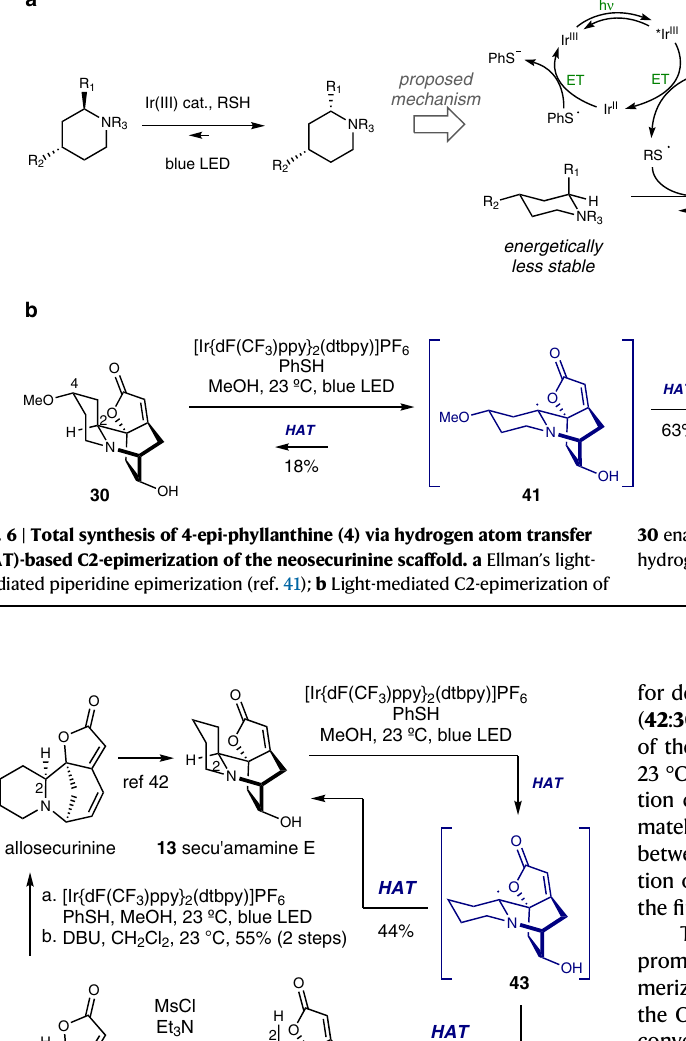
Fig. 7 | Interconversion between allosecurinine (2) and securinine (1) via HAT- based C2-epimerization. The light-mediated HAT-based epimerization of piper- idinesenabledtheinterconversionbetweensecu ’ amamineEand ent -virosineB,the neosecurinane derivatives of allosecurinine and securinine, respectively. Direct conversion of securinine to allosecurinine was also possible by the iridium- catalyzedHAT-basedepimerizationreactionbyemploying2equivofbenzenethiol and subsequent DBU-mediated E1cB reaction. DBU 1,8-diazabicyclo[5.4.0]undec-